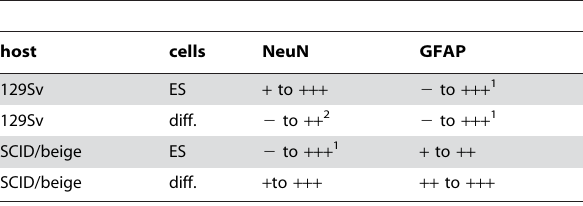
Table 4. Expression of neuronal and glial markers in teratomas grown in 129Sv and SCID/beige mice after injection of ES and differentiated cells.